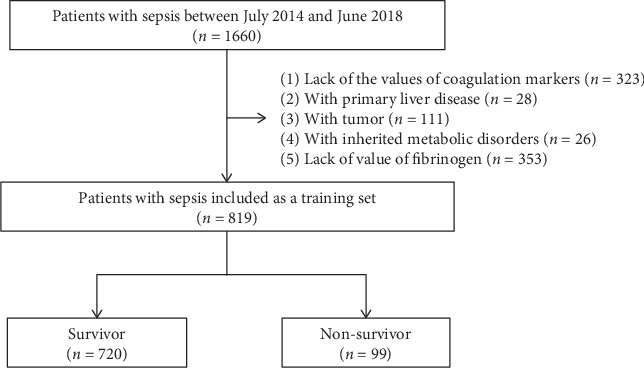
Flowchart of patients' selection in the training set.